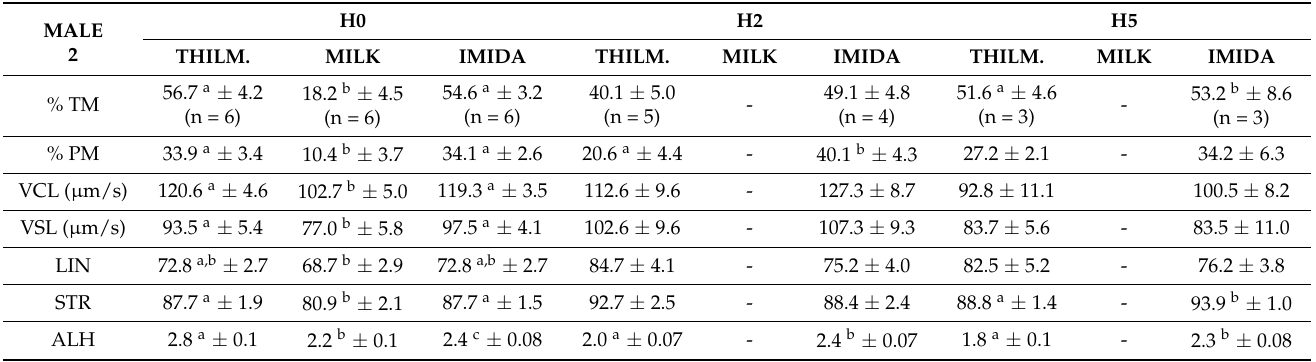
Table 7. Average semen parameters obtained by CASA system for male 2 in resistance test, according to extender (if there is no number: no motile spermatozoa reached that evaluation time with that